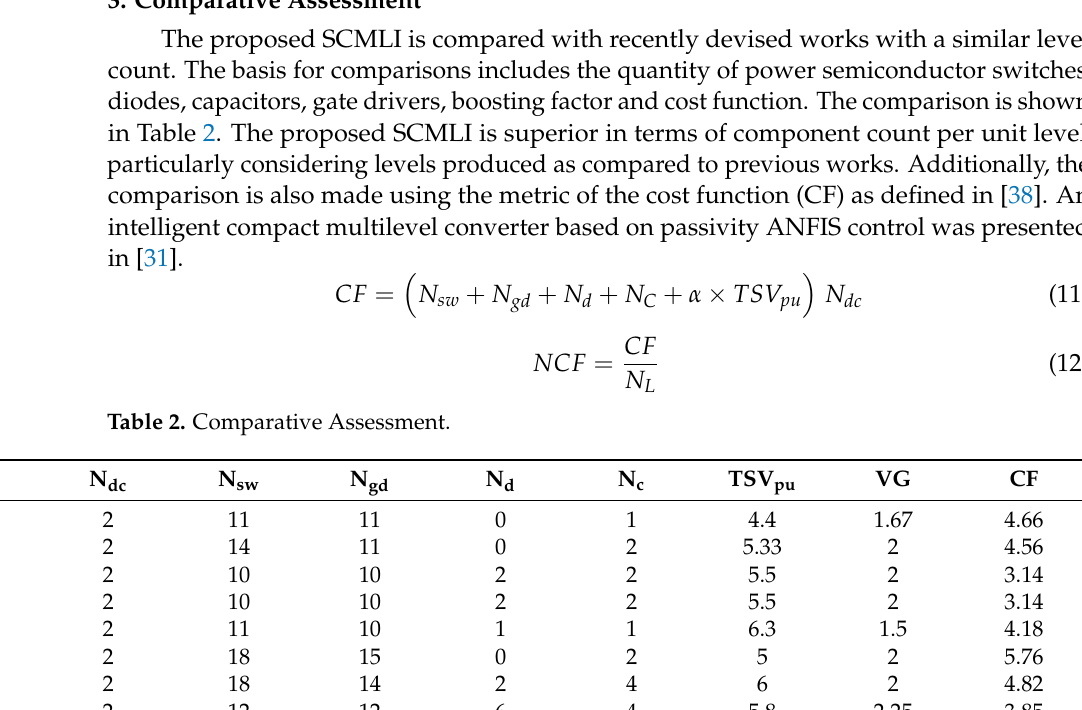
Table 2. Comparative Assessment.